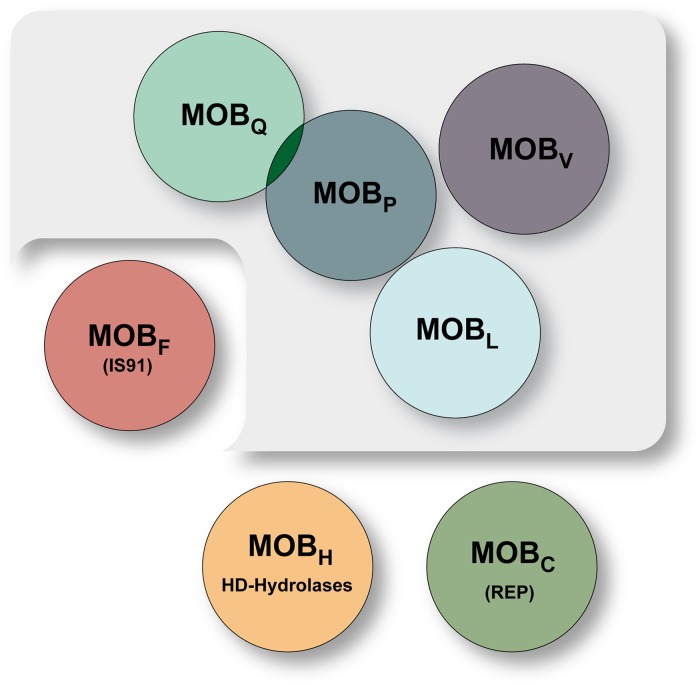
Schematic presentation of the relationships between the main relaxase protein families.The MOBQ, MOBV, MOBP, and MOBL families belong to one large cluster (shown on a grey background). The other MOB families are divided into three independent groups. Note that these overlap with other protein families having DNA nicking-closing activities such as the replication proteins of rolling-circle plasmids (REP), IS91-like transposases (IS91) or HD hydrolases. The MOBF family of relaxases contain a motif III that is also present in relaxases of the MOBQ, MOBP, MOBV and MOBL families. MOBP includes relaxases that are also classified as MOBHEN.